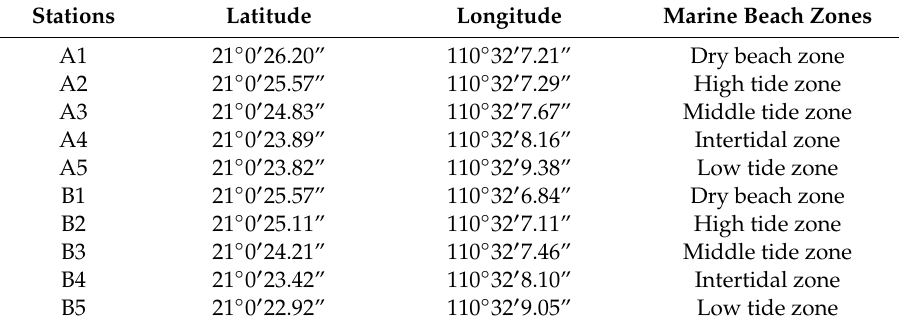
Figure 2. The landscape adjacent to land-based wastewater outlet and wastewater flow condition ( a ). Transect A and B represent the sampling area ( b ). Table 1. Sampling stations information of the marine sandy beach in the field